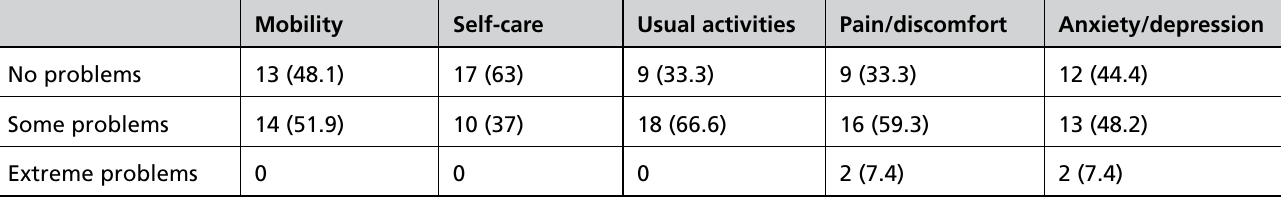
table ii: Descriptive item results of the eQ-5D six months after discharge expressed as number (percentage) (n = 27) Mobility